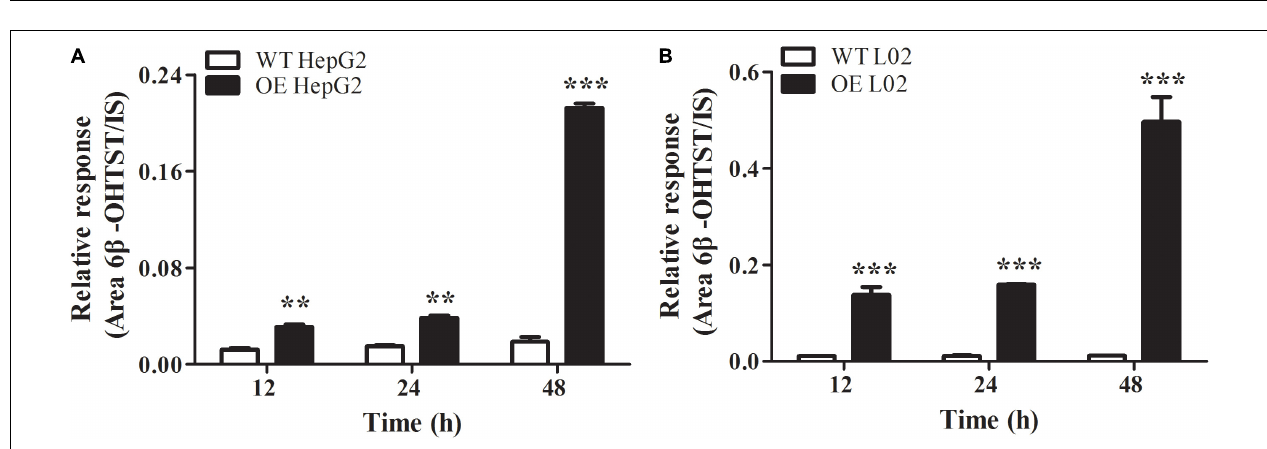
FIGURE 6 | Oxidation of testosterone to 6 β -hydroxyl-testosterone in WT and CYP3A4 OE HepG2 cells (A) and L02 cells (B) . Values are represented as mean ± SD ( n = 3). ∗ p < 0.05, ∗∗ p < 0.01, ∗∗∗ p < 0.001 vs. WT groups.